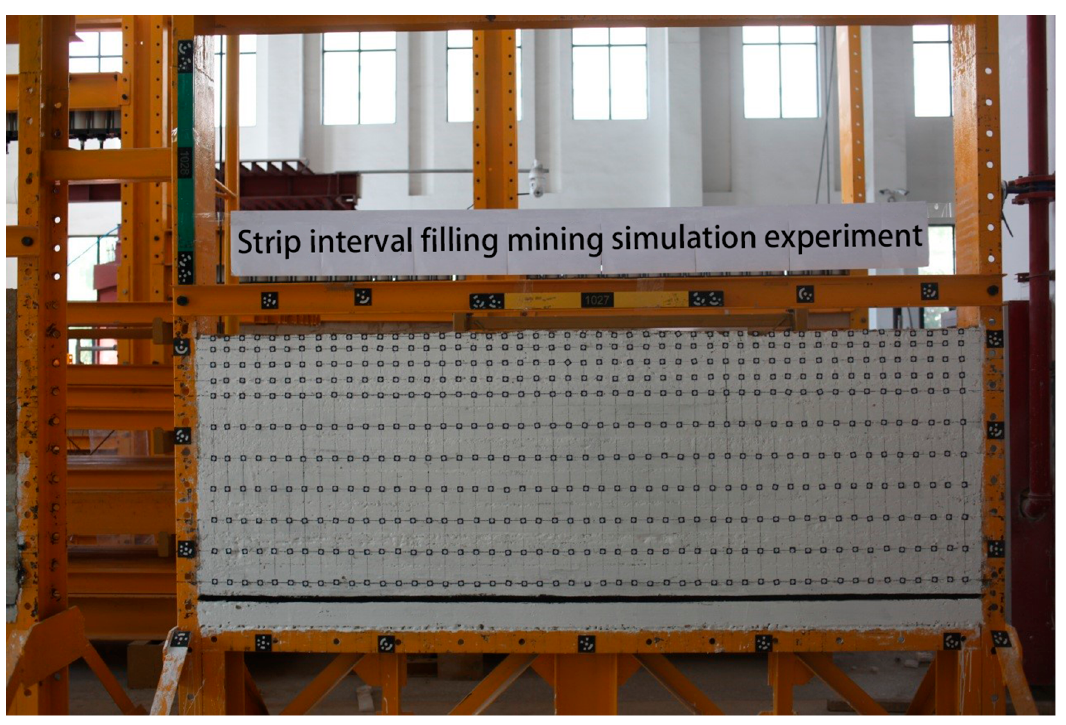
Figure 20. Model measurement point layout.